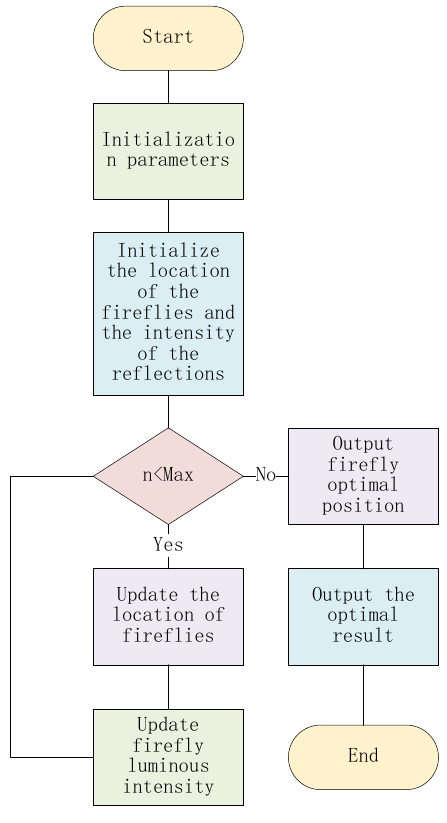
Figure 2. The flow chart of the firefly